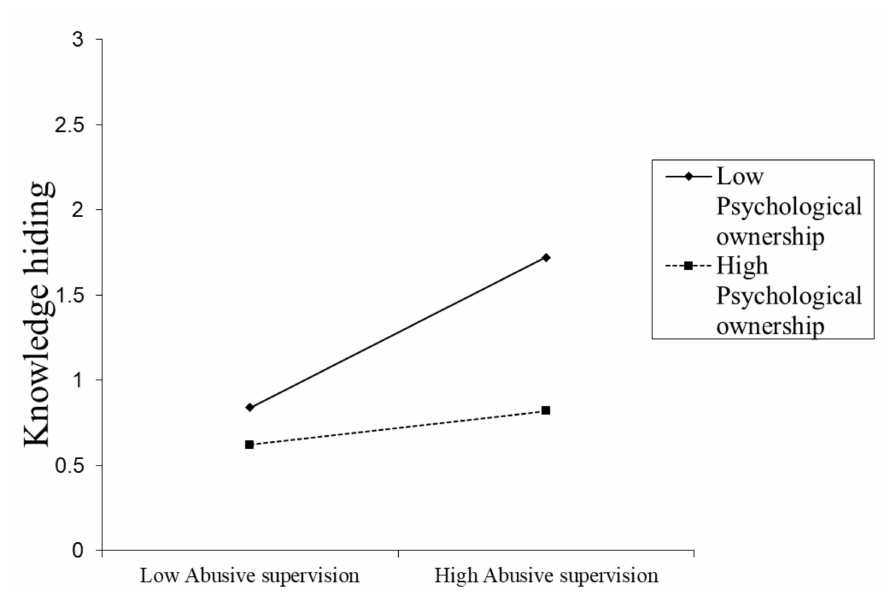
Figure 2. Moderation e ff ect of psychological ownership on abusive supervision and a knowledge hiding